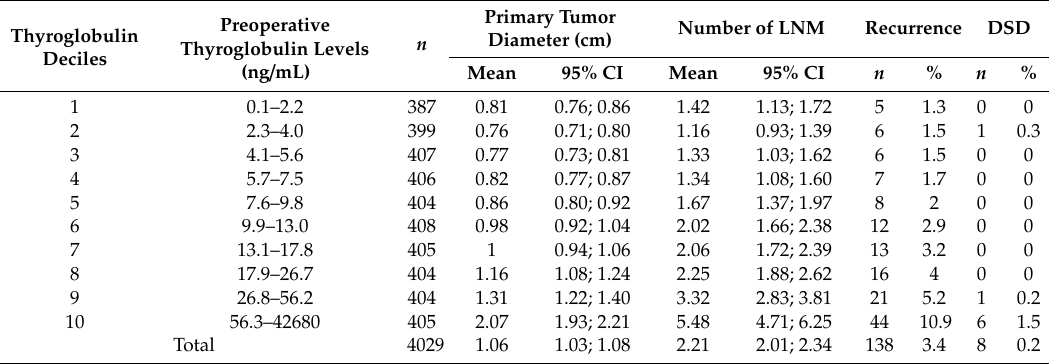
Thyroglobulin deciles: the deciles of patients with di ff erent levels of preoperative thyroglobulin levels (levels increase from 1 to 10). LNM—lymph node metastases, DSD—disease-specific death, CI—confidence interval. Moreover, when the mean number of LNM and mean tumor size is plotted against each decile of increasing thyroglobulin (Figure 1), a sharp increase can be seen in both tumor size and LNM when the preoperative thyroglobulin level exceeds 17.9 ng / mL (the lower level for the eighth decile) and 26.8 ng / mL (the lower level for the ninth decile), respectively (Figure 1). Subgroup analyses for papillary thyroid carcinoma and follicular thyroid carcinoma are provided as supplementary data (Supplementary Materials Tables S1 and S2; Figures S1 and